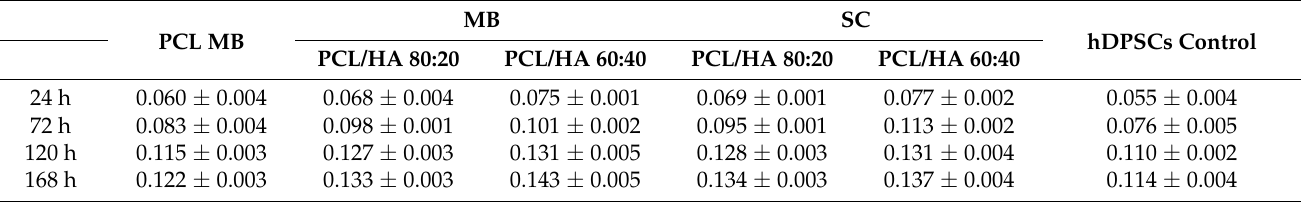
Table 5. Cytocompatibility assessed by Presto Blue TM viability assay for hDPSCs. Results of % viability inhibition are presented in mean ± SE, normalized to the PCL MB as 0%.